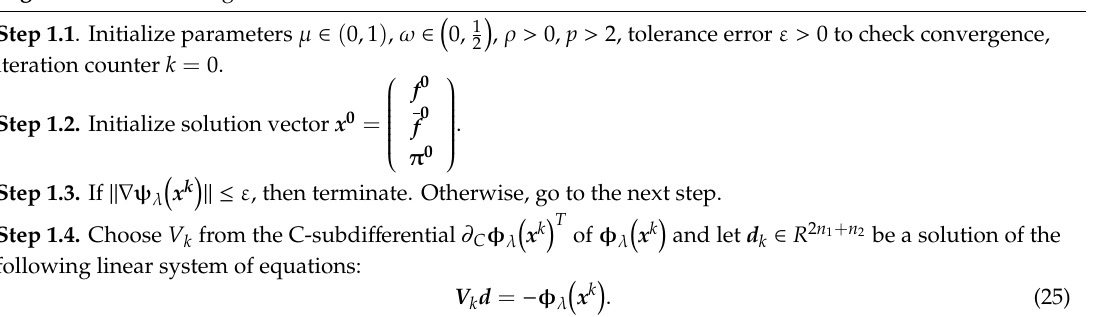
Algorithm 1 . Global algorithm.